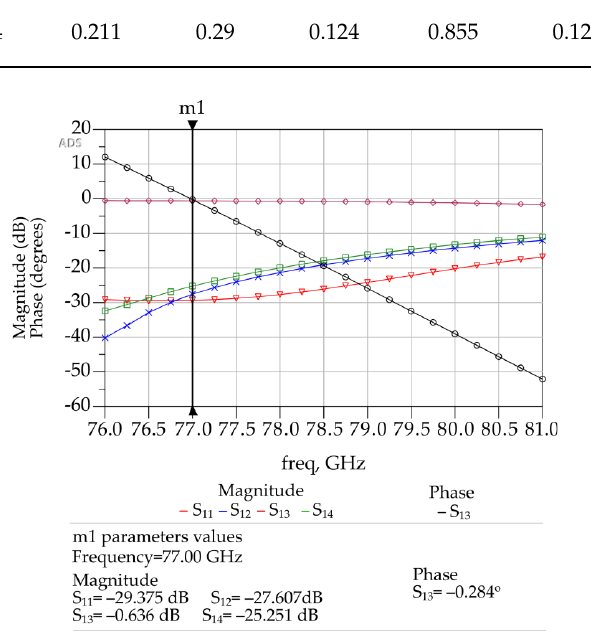
Figure 9. ADS generated 3D FEM simulation results for the type-1 crossover. Table 5. Optimized dimensions of the type-1 crossover.